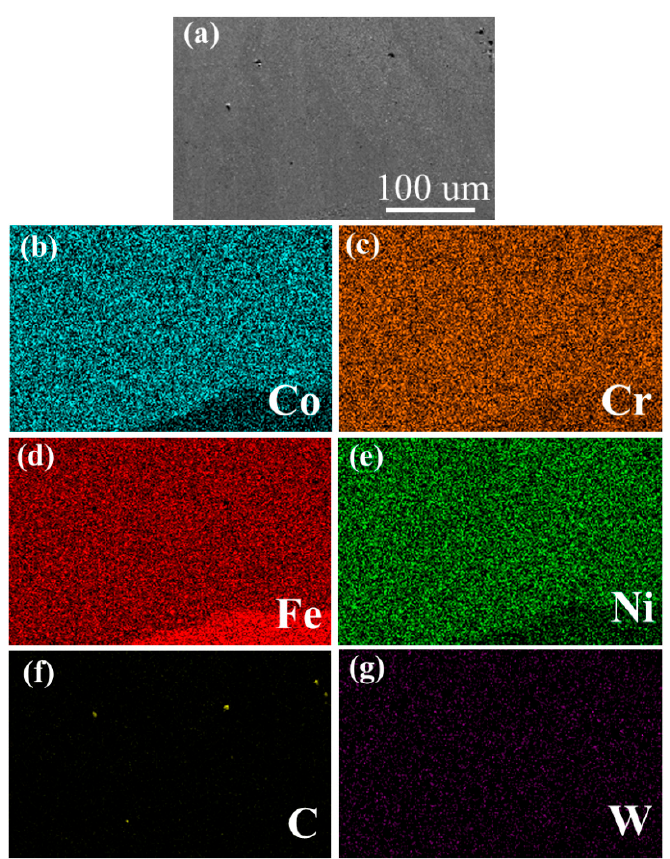
Figure 4. EDS mapping of CoCrFeNi HEA coating of sample A. ( a ) SEM of the CoCrFeNi HEA coating; ( b ) Co element distribution; ( c ) Cr element distribution; ( d ) Fe element distribution; ( e ) Ni element distribution; ( f ) C element distribution; ( g ) W element distribution.